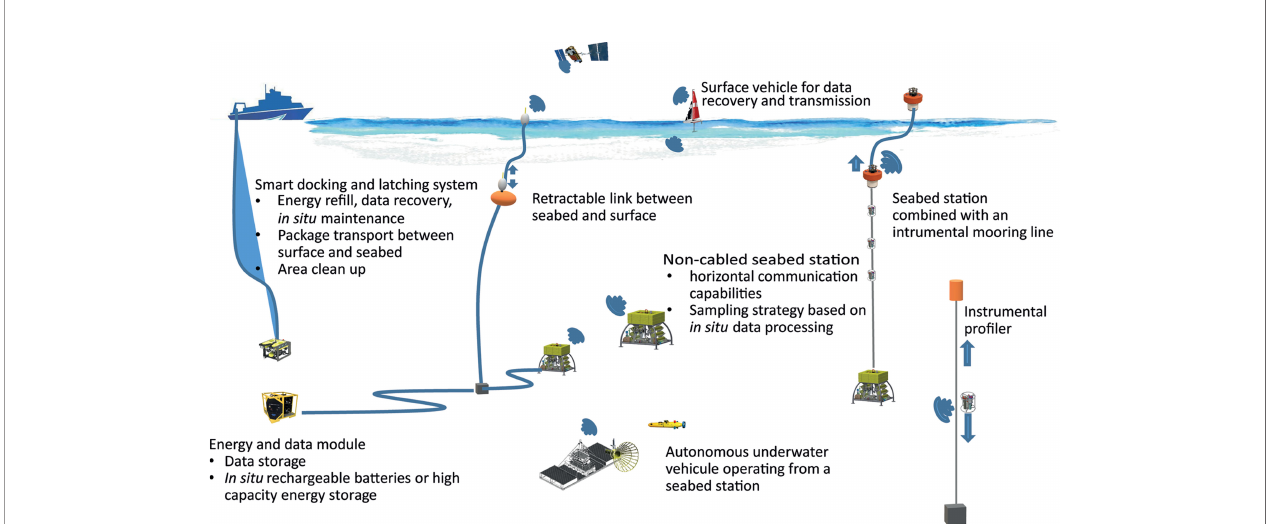
FIGURE 7 | Illustration of future technological and operational breakthroughs to reduce deployment and maintenance cost and reduce environmental